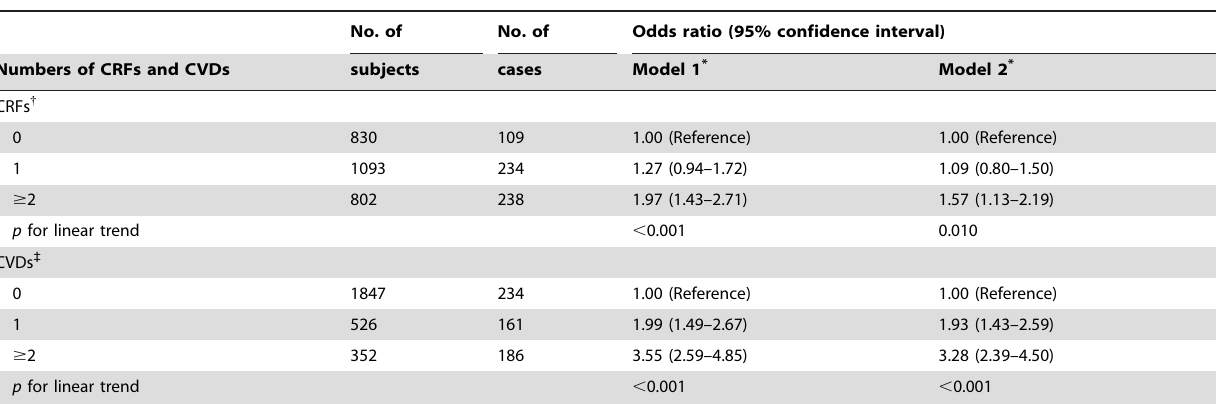
Table 3 . Odds ratios (95% confidence interval) of mobility limitation associated with clustering of CRFs and CVDs in the total sample (n